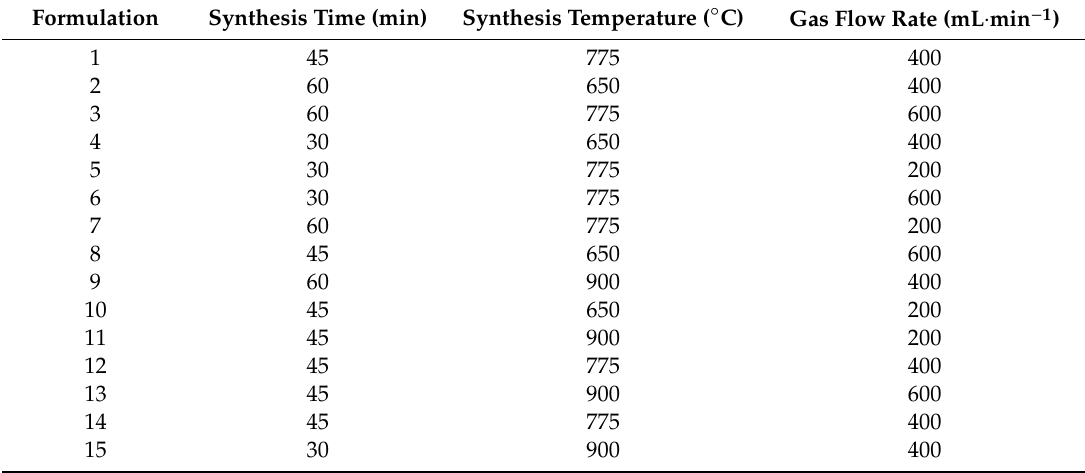
Table 3. Formulation variables as per the Box-Behnken